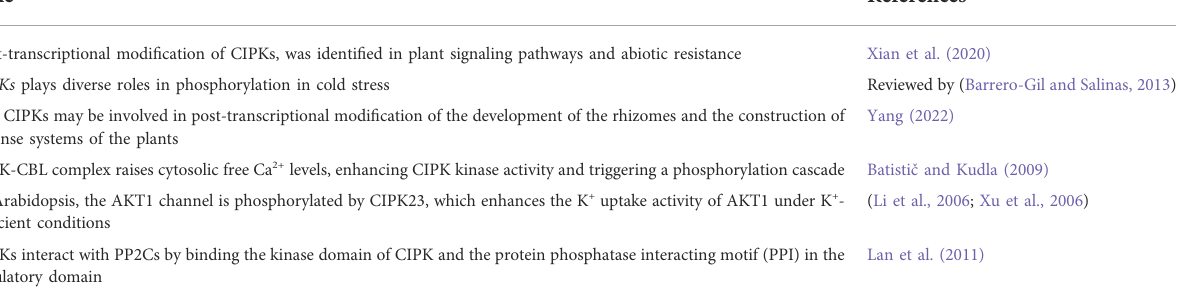
TABLE 3 CIPK roles in transcriptional and post-transcriptional regulation in different plants.